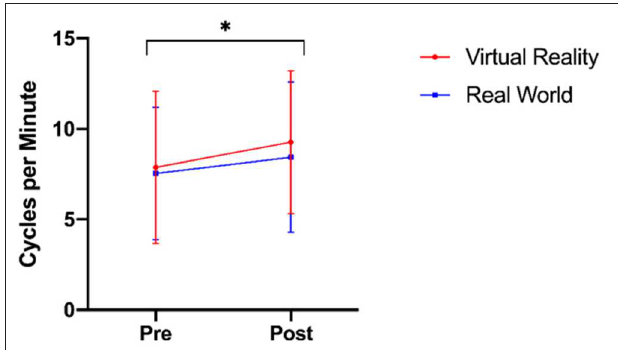
FIGURE 2 | Accommodation facilities before and after training in both virtual-reality and real-world training groups (* denotes p < 0.05).